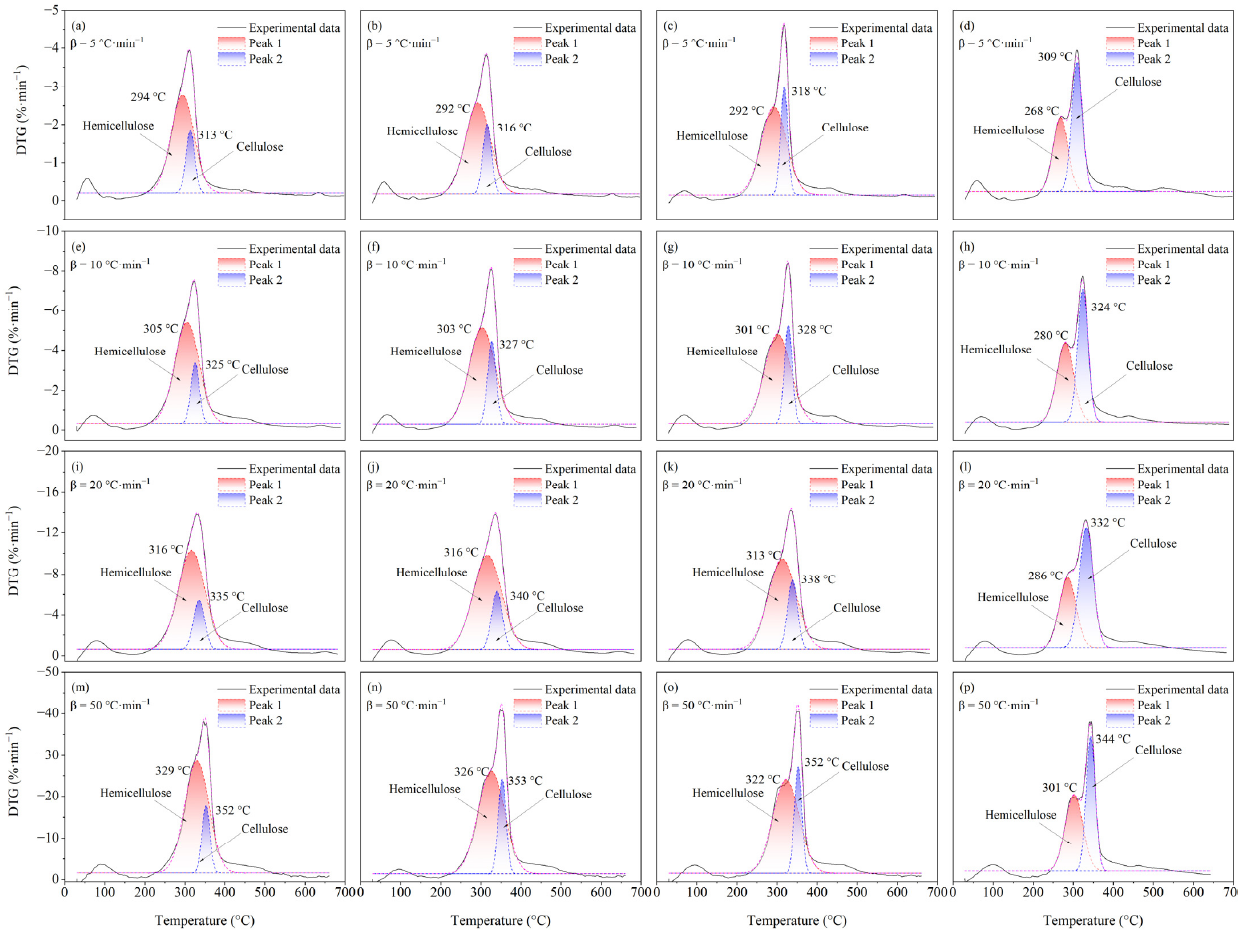
Figure 7. The separate DTG curves of hemicellulose component and cellulose component in rice straw with different Cd loading. ( a , e , i , m ) are the RS; ( b , f , j , n ) are the RS-0.1%Cd; ( c , g , k , o ) are the RS-1%Cd; ( d , h , l , p ) are the RS-5%Cd, respectively.